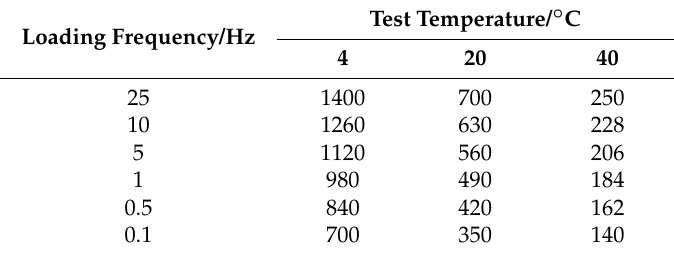
Table 5. The number of loading cycles of DM test.